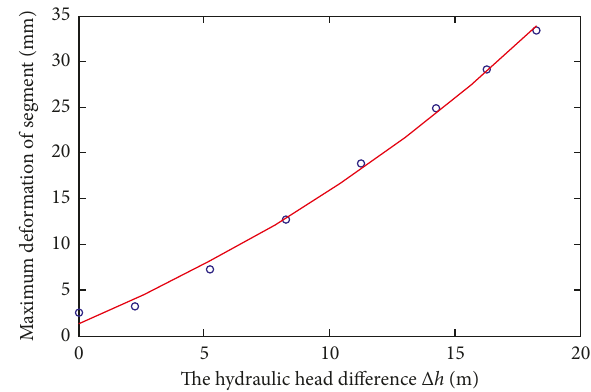
Figure 23: The relationship between the maximum deformation of the segment and the water head